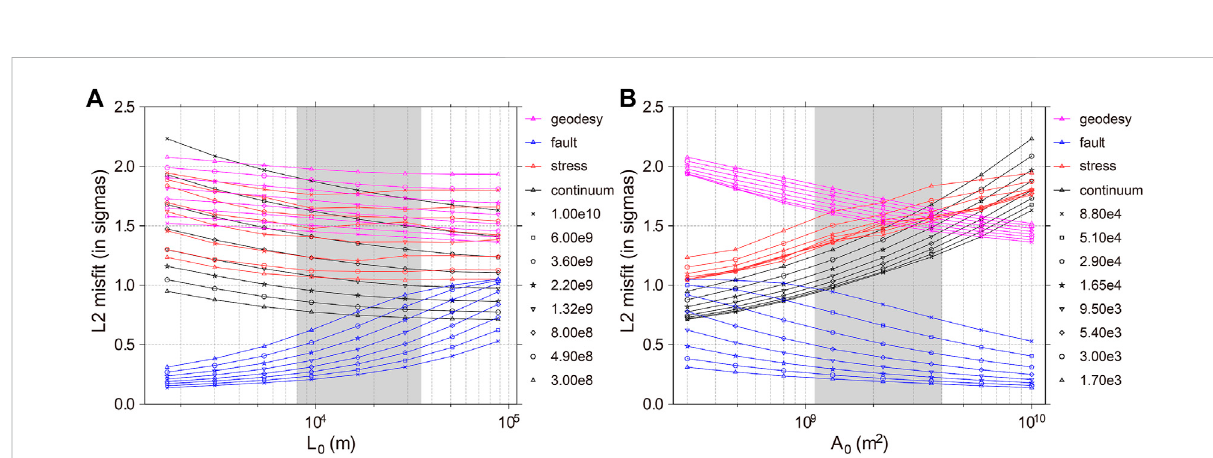
FIGURE 4 The L2-norm mis fi t errors of continuum strain rate, stress direction, fault slip rate and geodetic velocity under the model with different combinations of L 0 and A 0 . (A) Reference length L 0 versus the L2-norm mis fi t errors; (B) Reference length L 0 versus the L2-norm mis fi t errors. Continuum strain-rate,stressdirection,faultsliprateandgeodeticvelocityerrorsarerepresentedbysymbolsandconnectedlinesinblack, red,blue and magenta, respectively. Different symbols represent mis fi t errors versus L 0 at different A 0 . Grey shadow shows the preferred range of L 0